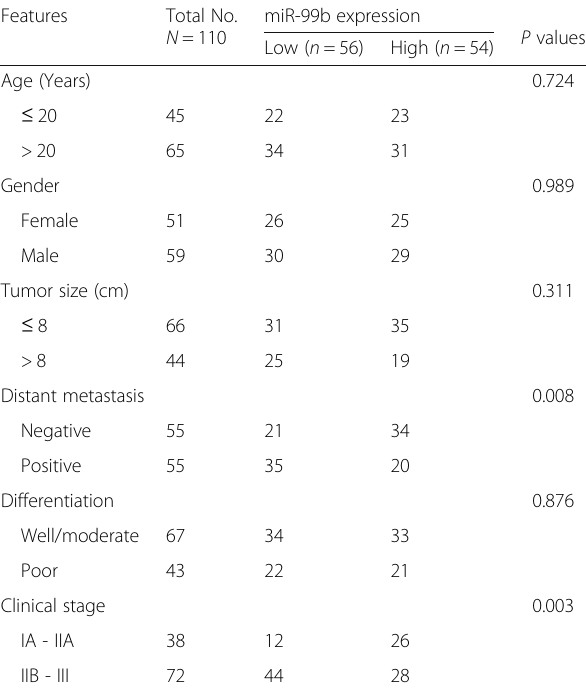
Table 1 Association of miR-99b and the clinical characteristics of the OS